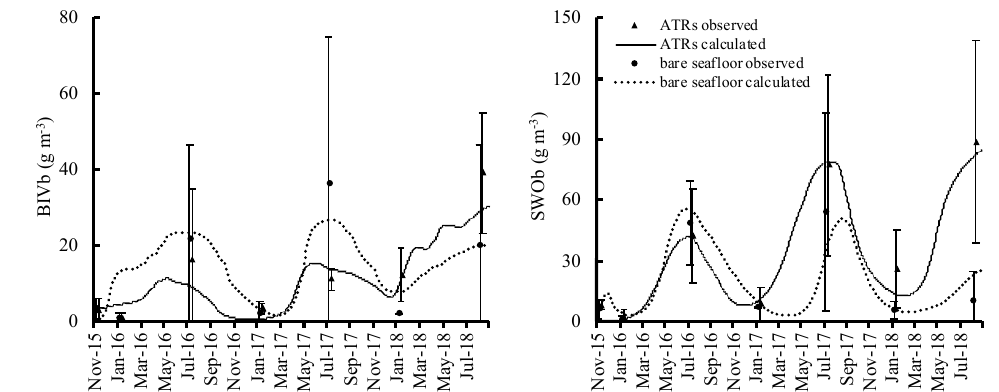
Figure4. Figure 4. Relative temporal changes in benthic organisms in artificial timber reefs and bare seafloor areas.